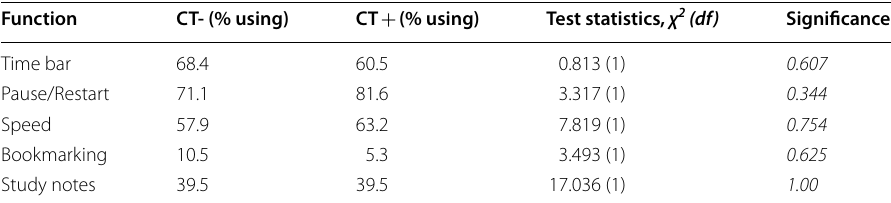
Table 3 Percentage of students using specific functions of lecture capture (N Function CT- (% using) CT